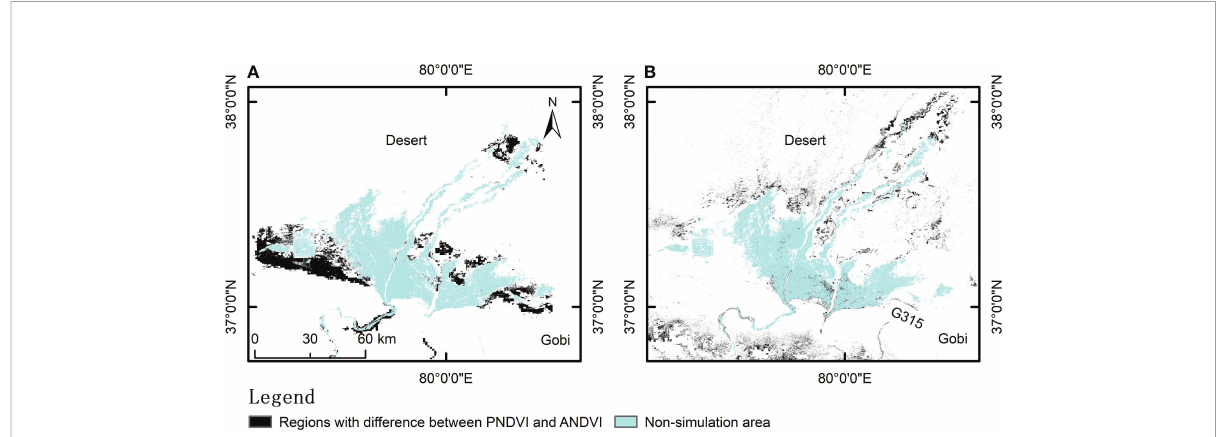
FIGURE 8 Regions with difference between PNDVI and ANDVI. (A) represents the region where PNDVI with high vegetation and ANDVI with bare or sparse vegetation; (B) represents the region where PNDVI with bare or sparse vegetation and ANDVI with low